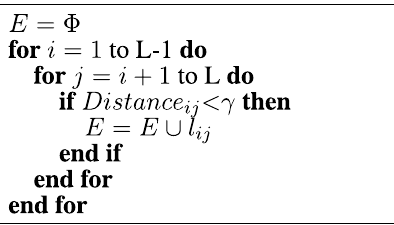
Algorithm 1. Graph